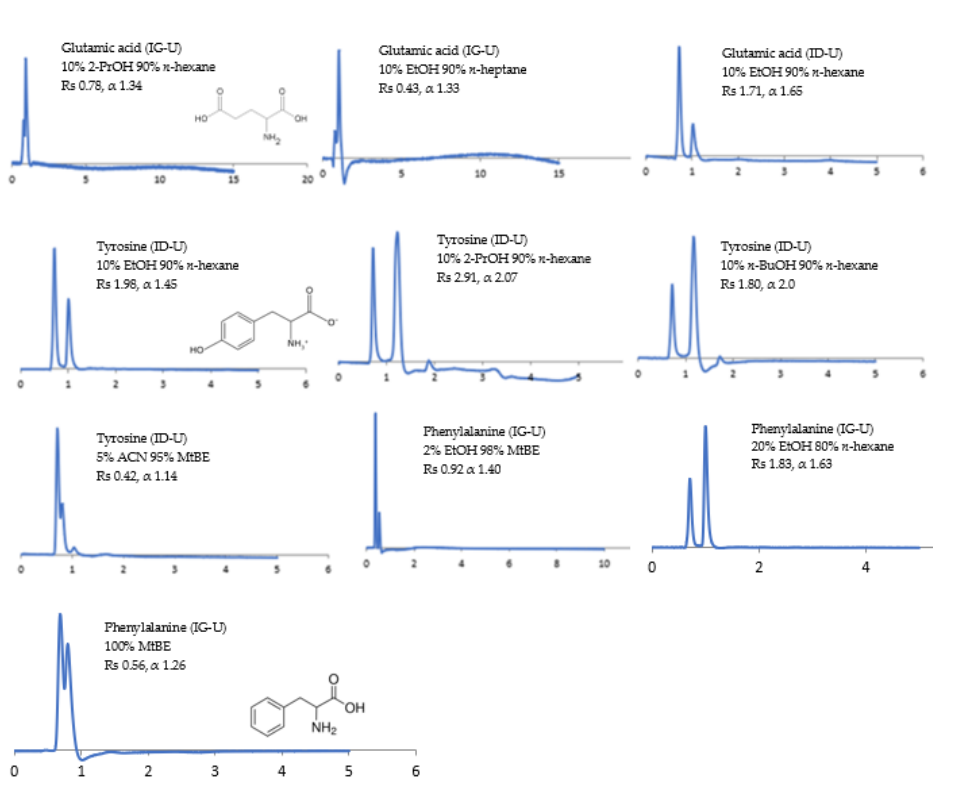
Figure 6 Figure 6. Enantioselectivity of three amino acids under different mobile phase